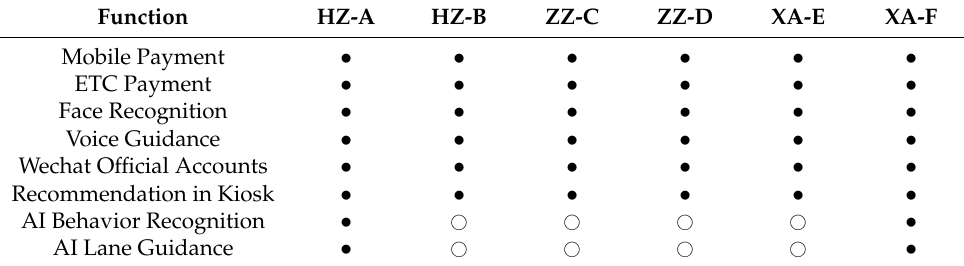
Table 2. Basic functional information of six interviewed gas stations.